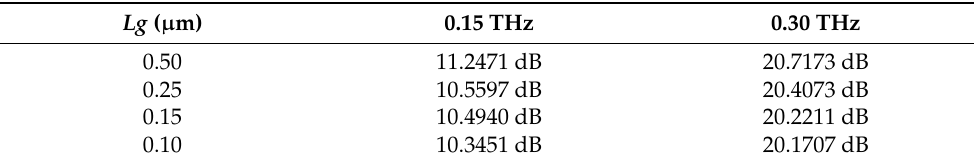
Table 2. Maximum value of the normalized electric field component along y axis in dB for frequencies 0.15 and 0.30